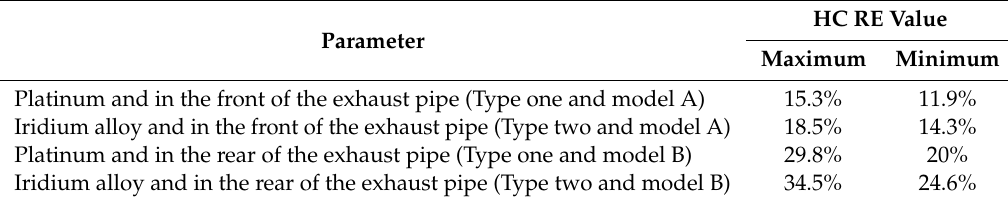
HC RE Value Maximum